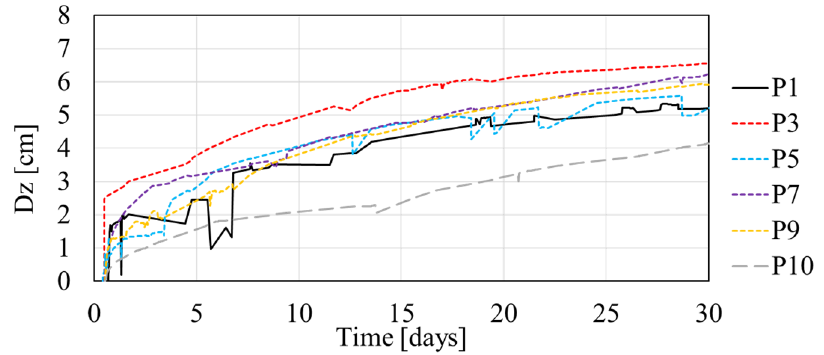
Figure 16. Change in the surface level of the soil during field test.